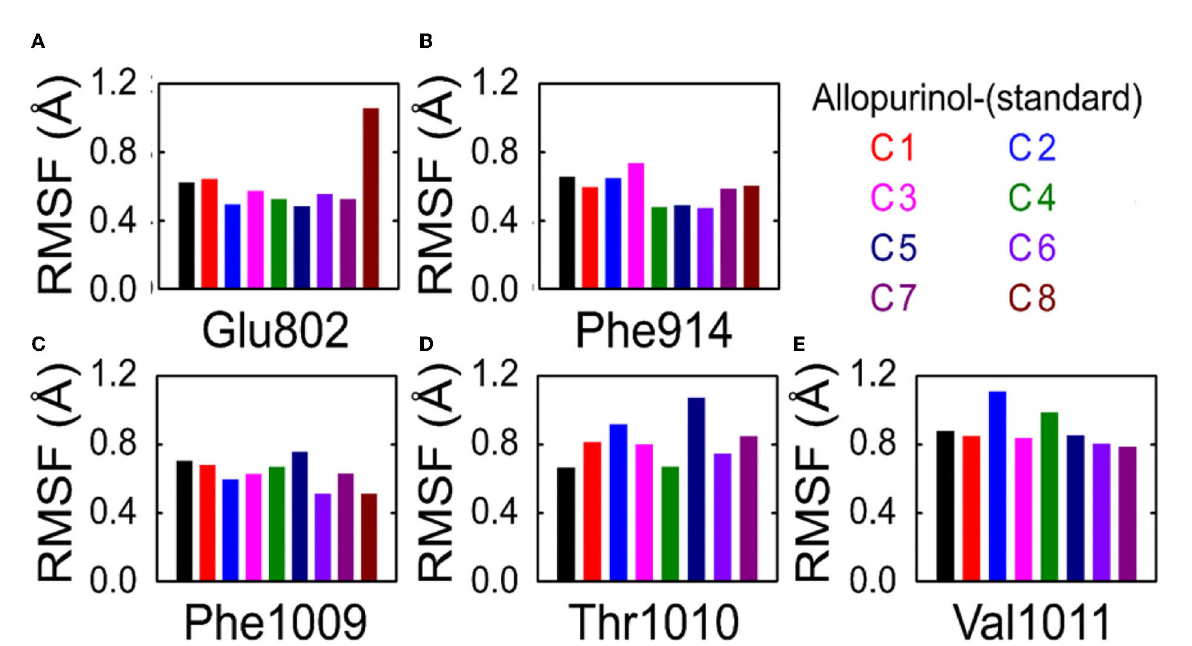
FIGURE6 RMSF analysis of key residues in allopurinol and phenolic compounds. (A) Glu802; (B) Phe914; (C) Phe1009; (D) Thr1010; and (E) Val1011. RMSF, root-mean-square fluctuations; C1, quercetin; C2, quercetin-3-rhamnoside; C3, 4,5-O-dicaffeoylquinic acid; C4, 3,5-O-dicaffeoylquinic acid; C5, 3,4-O-di-caffeoylquinic acid; C6, 4-O-caffeoylquinic acid; C7, 3-O-caffeoylquinic acid; and C8, caffeic acid.